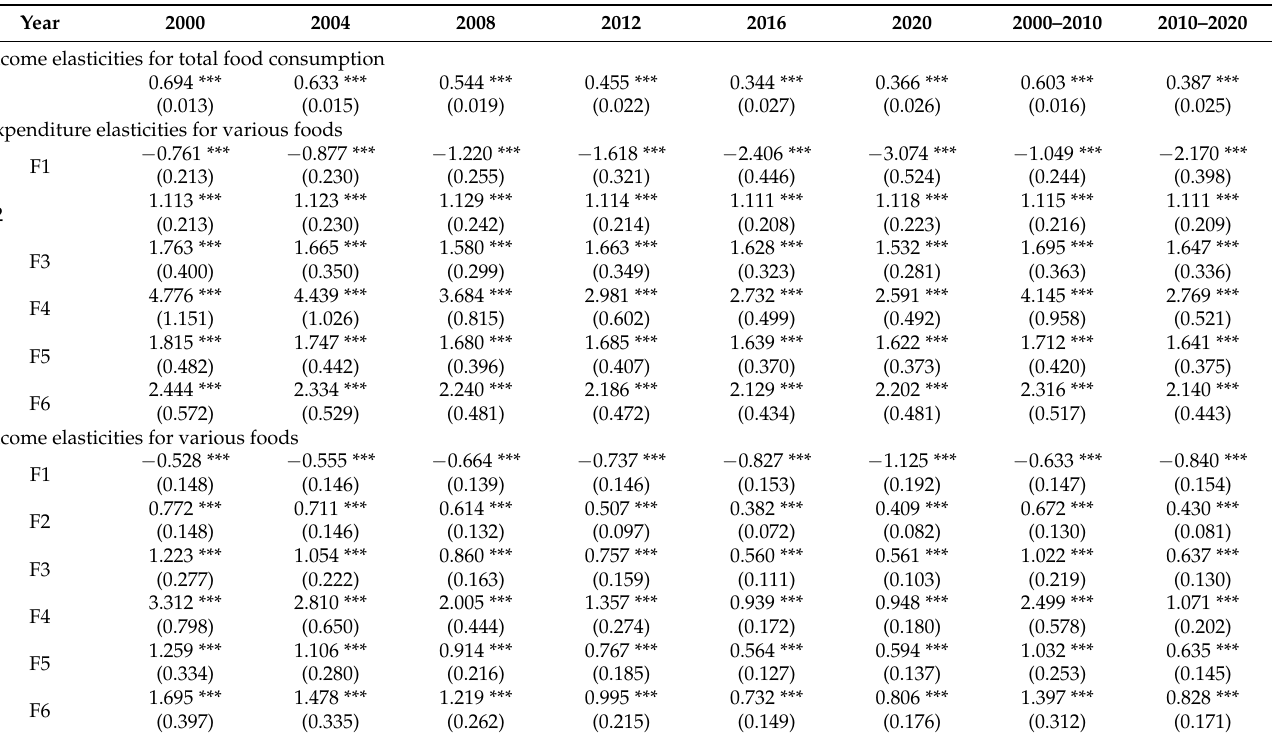
Figure 2. Per capita expenditure shares of various food groups from 2000 to 2020. Table 3. Expenditure and income elasticities for various food groups from 2000 to 2020.